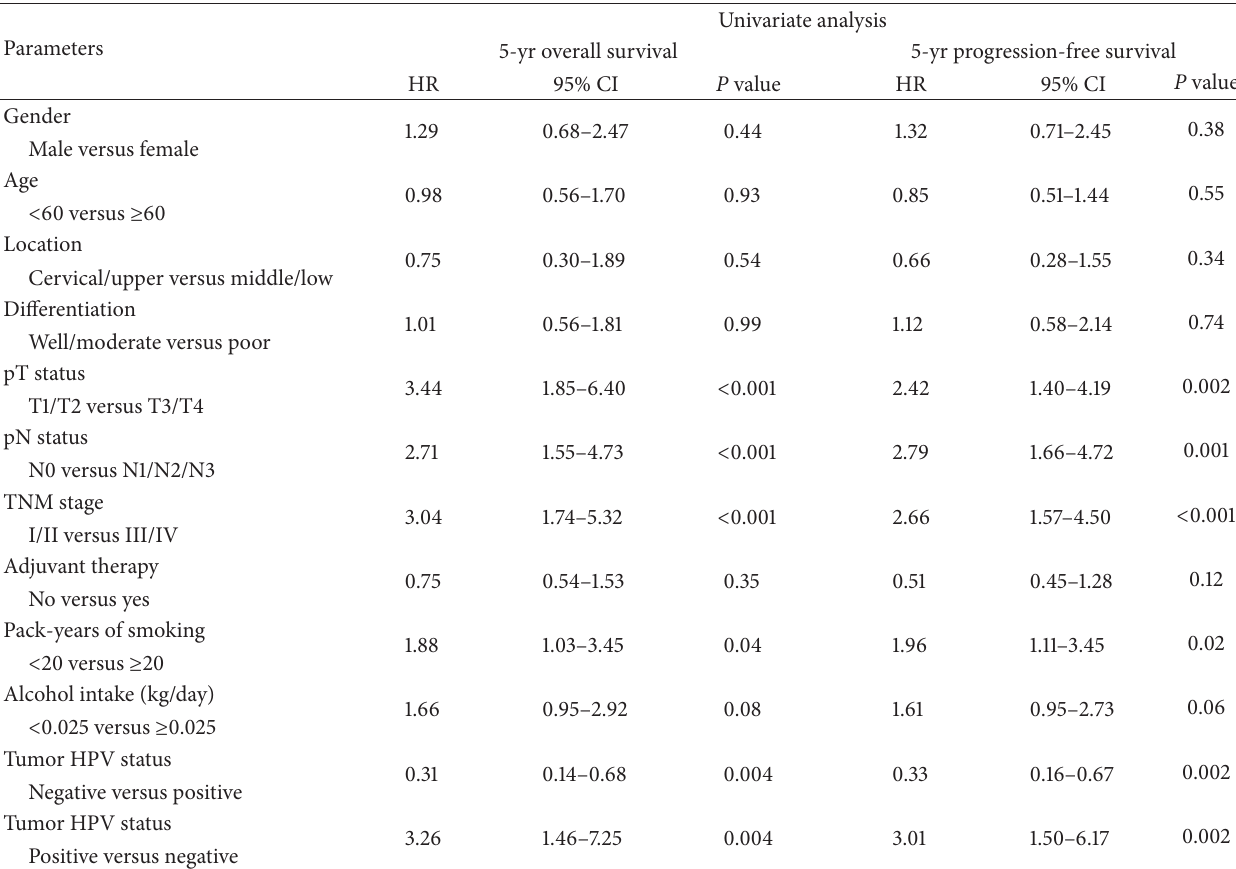
Table 3: Cox univariate analysis for 5-year survival and progression-free survival in the study patients with esophageal squamous cell